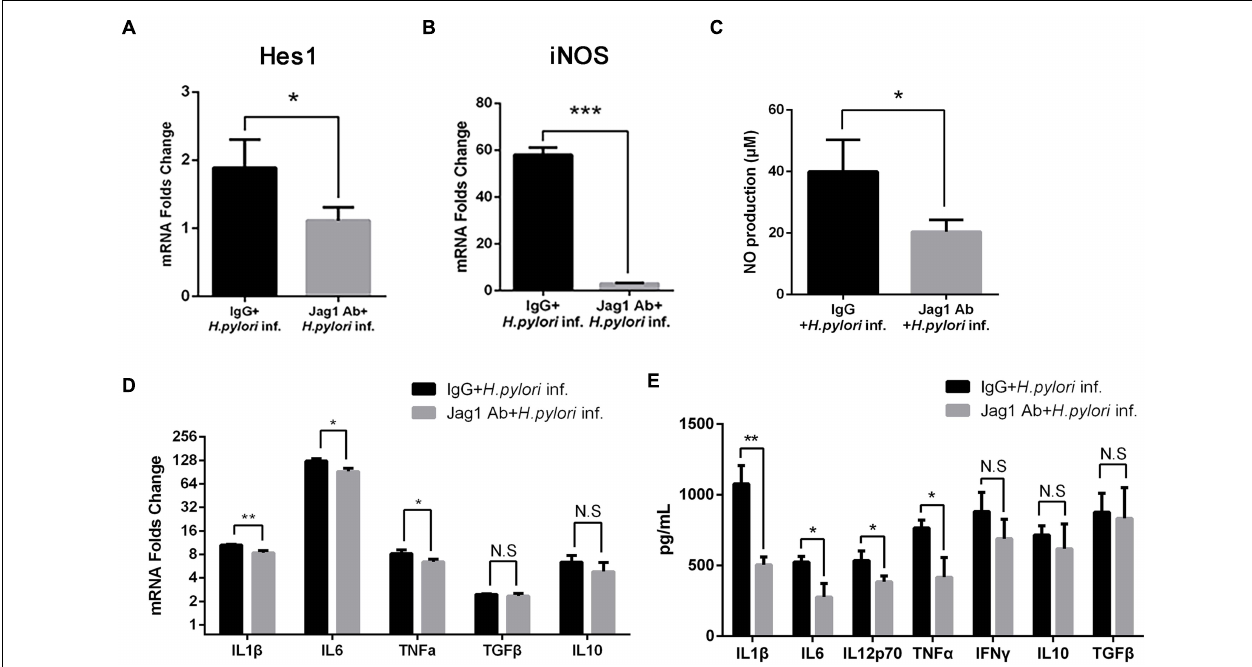
FIGURE 8 | Jagged1 antibody enhances the secretion of pro-inflammatory mediators in RAW264.7 cells against H. pylori infection. RAW264.7 cells were pretreated with 3 µ g/ml Jagged1 Ab and then co-cultured with H. pylori (MOI = 50) for 12 h. Mouse IgG was used as control for anti-Jagged1 Ab. PBS was used as control for H. pylori . Total RNA of each group was extracted. (A) qPCR was performed to examine the mRNA expression of Hes1. (B) qPCR was performed to examine mRNA expression of Jagged1. (C) Griess was performed to assess the production of NO in the supernatant. (D) qPCR was performed to examine the mRNA expression of proinflammatory cytokines IL1 β , IL6, and TNF α and anti-inflammatory cytokines IL10 and TGF β . (E) ELISA was performed to examine the protein level of proinflammatory cytokines IL1 β , IL6, IL12p70, TNF α , and IFN γ and anti-inflammatory cytokines IL10 and TGF β in the supernatant. IgG + H. pylori inf: Mouse IgG-pretreated and H. pylori infected group; Jag1 Ab + H. pylori inf.: anti-Jagged1 Ab-pretreated and H. pylori -infected group. β -actin was used as reference gene. Data are presented as the mean ± SD of three independent experiments. * p < 0.05, ** p < 0.01 and *** p < 0.001; N.S. represents no significant difference.